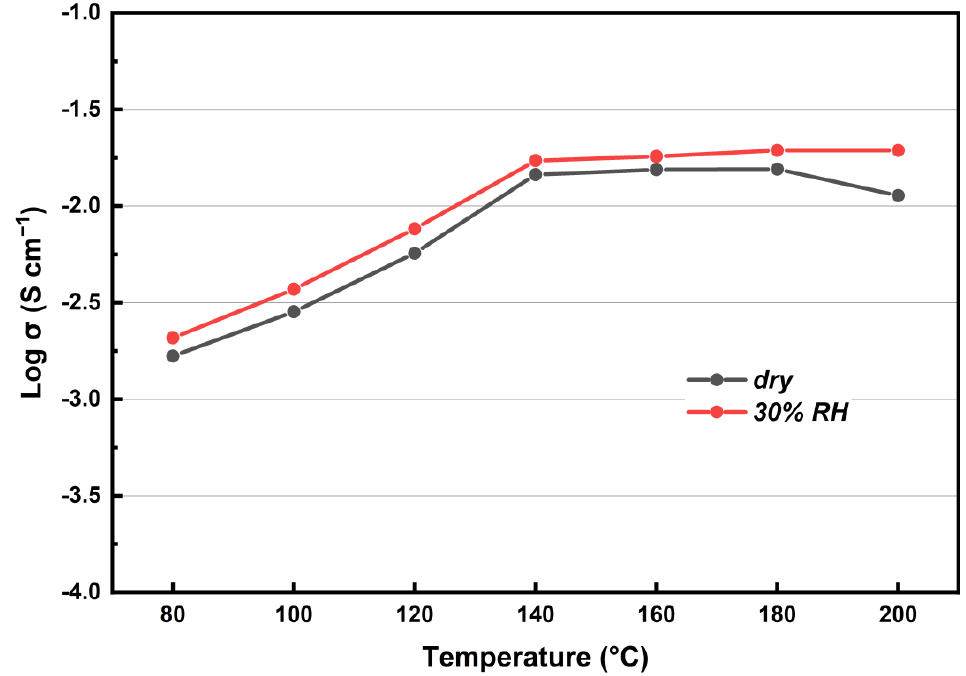
Figure 6. Proton conductivities of the KH 5 (PO 4 ) 2 -doped PBI membrane in temperature range from 80 °C to 200 °C.